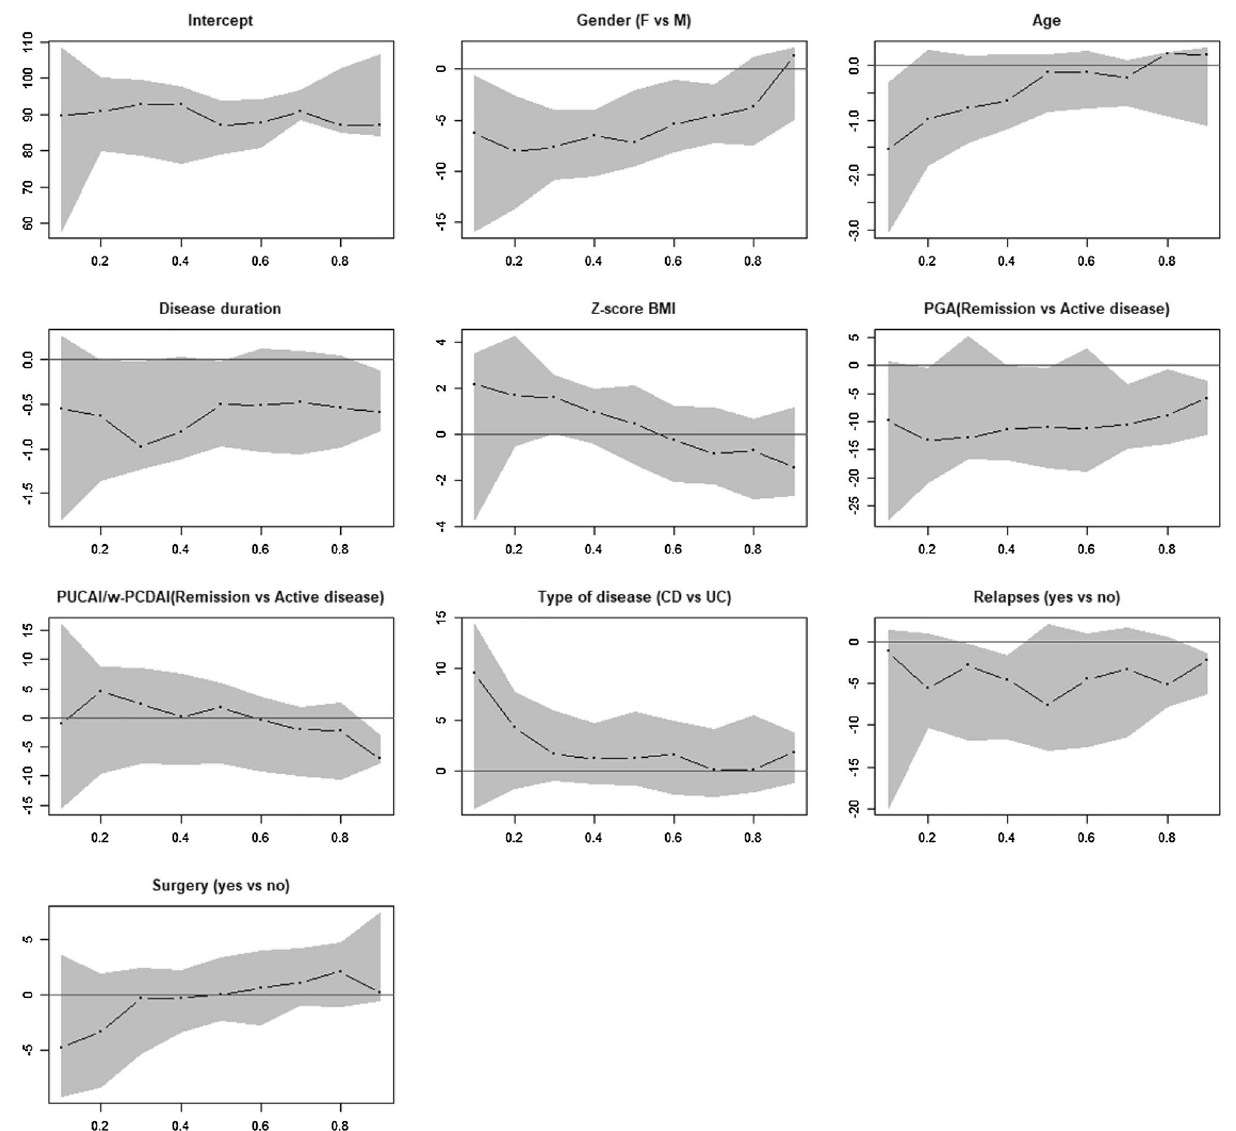
diagnosis were associated with better QoL related to bowel symptoms (subjects with CD with a median score higher of 5 points compared to patients with UC). Both gender (females reporting 12 points less than males) and relapses had negative significant association with the Emotional Functioning domain. Social Functioning domain was significantly associated with disease duration, a longer history of disease being associated to a worse social functioning. Female gender, older age, longer disease duration and UC diagnosis were negatively associated with the QoL related to systemic symptoms. Body Image score significantly decreased with increasing age (in median of three point for each year of age). Treatment/Intervention score was significantly lower in females than males. The domain score significantly decreased with longer disease duration and in presence of active disease, as evaluated by clinicians (PGA). Figure 2 shows the effect of each variable on the IMPACT-III total score. Gender had a significant negative effect in the first 7 deciles of the distribution, while age was significantly associated with the total score in the first decile (subjects reporting the lowest QoL). Active disease, measured by PGA index, decreased the quality of life in the last three deciles of the score distribution (subjects with the highest QoL).